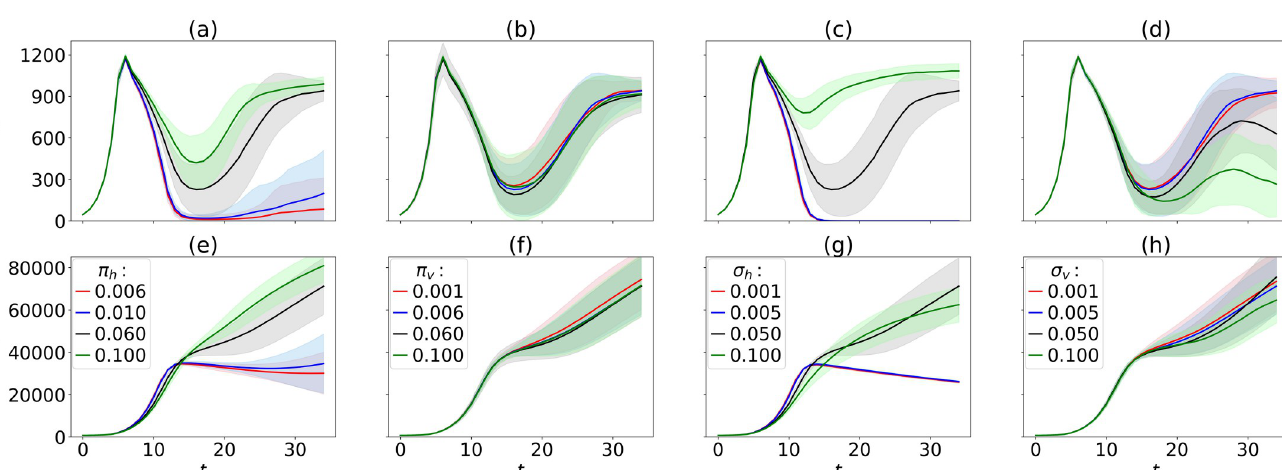
), virus traits ( π ), h v